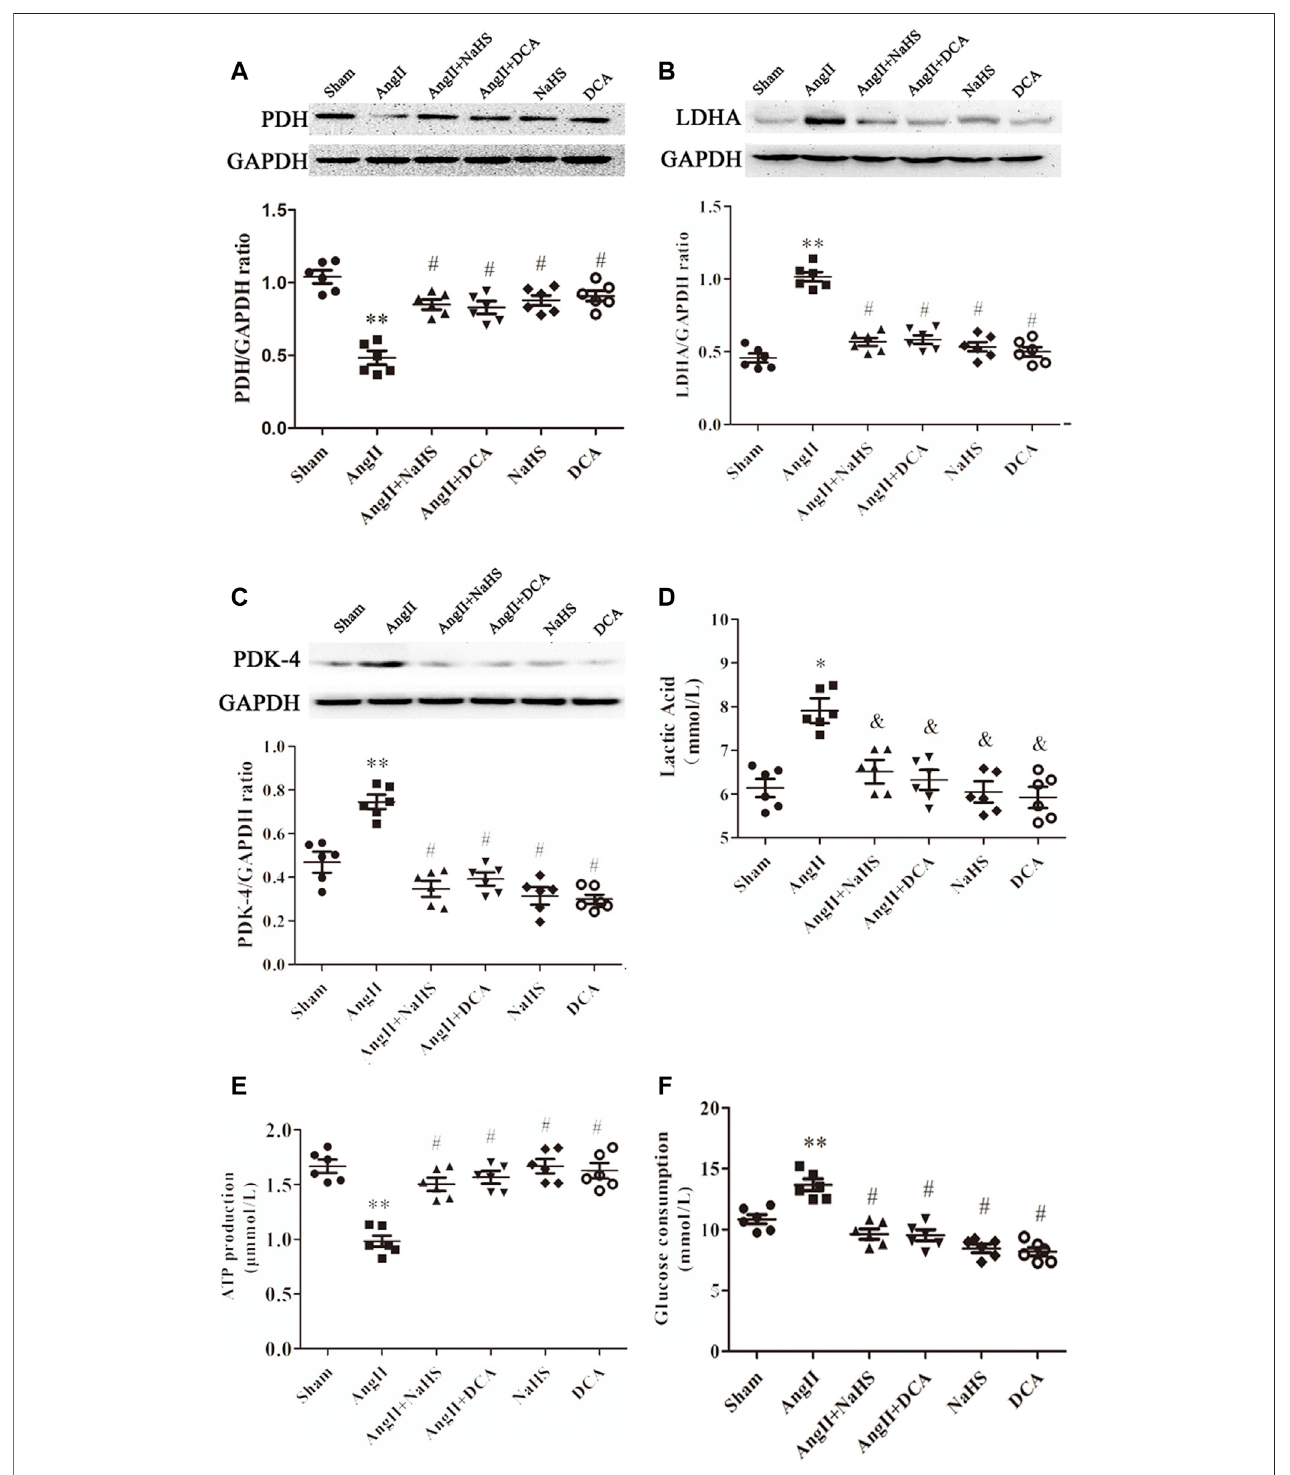
FIGURE 2 | NaHS attenuated the Warburg effect in the left atrium gained from rats under Ang-II treatment. Representative Western blotting and relative densitometry analysis of (A) PDH, (B) LDHA and (C) PDK-4 with GAPDH as aloading control in the rats left atrial tissue of the indicated groups. Lactate acid (D) and the productionofATP (E )andglucoseconsumption (F) weredeterminedbykitanalysisintheratsleftatrialtissueoftheindicatedgroups ( n (cid:1) 6ineachgroup ) . **p < 0.01VS Sham, *p < 0.05 VS Sham, #p < 0.01 VS Ang II, &p < 0.05 VS Ang II. Groups were compared using one-way analysis of variance (ANOVA) (Tukey ’ s) in (A – F) .